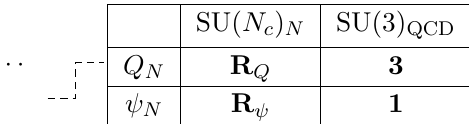
Table 6 . Another possible termination of the chain of connected modules, which breaks the U(1) A symmetry by the QCD